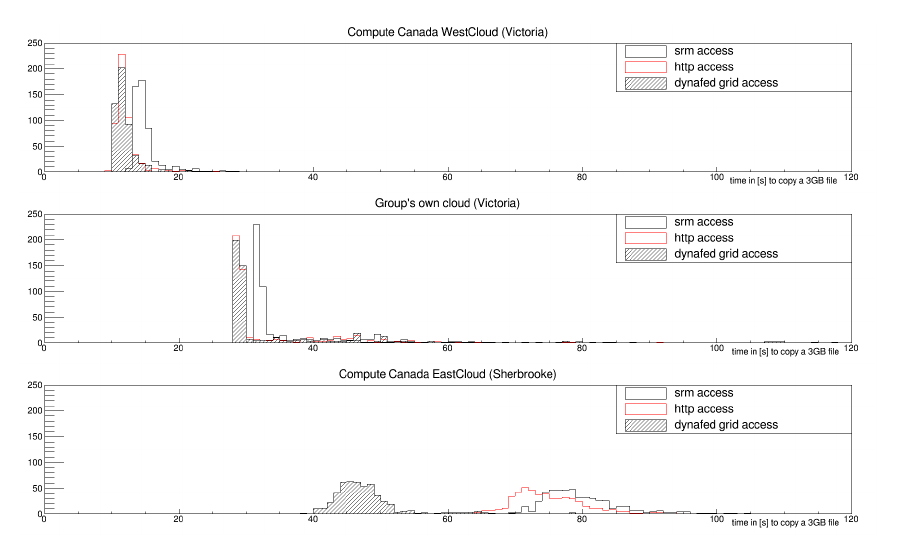
Figure 4: Time distribution for copying 500 3GB files directly from the UVic Grid storage, Figure 5: Time distribution for copying 500 3GB files with access through Dynafed using initiated by clients on di ff erent clouds using the HTTP protocol (in red); in addition to previ- Grid sites as endpoints behind Dynafed (black striped histogram); initiated by clients on ous test distributions. di ff erent clouds and in addition to previous test